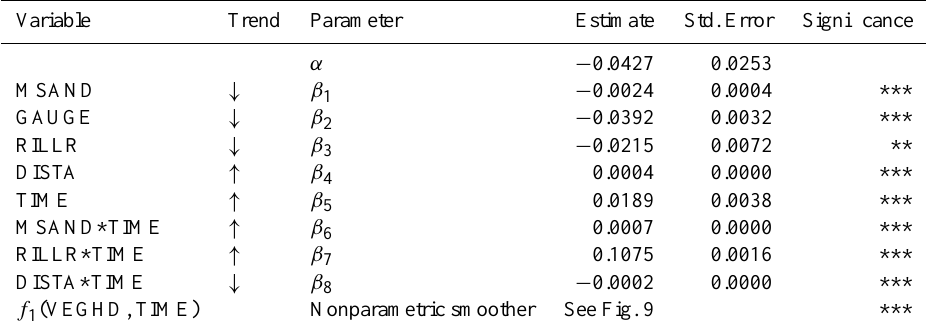
Table 13. Parameter estimates and significances for the model estimating surface height change (DHEIGHT) as shown in Eq. (17). Sig- nificance levels: ***: p < 0.001, **: p < 0.01, *: p < 0.05. The variance of the random effect a in Eq. (17) is 0.0006. Trend: qualitative illustration of linear predictor variables’ significant influences. ↑ , ↓ : DHEIGHT increases (decreases) with increasing values of the respec- tive predictor variable. Thus, ↓ indicates a tendency towards erosion while ↑ indicates trends that counteract